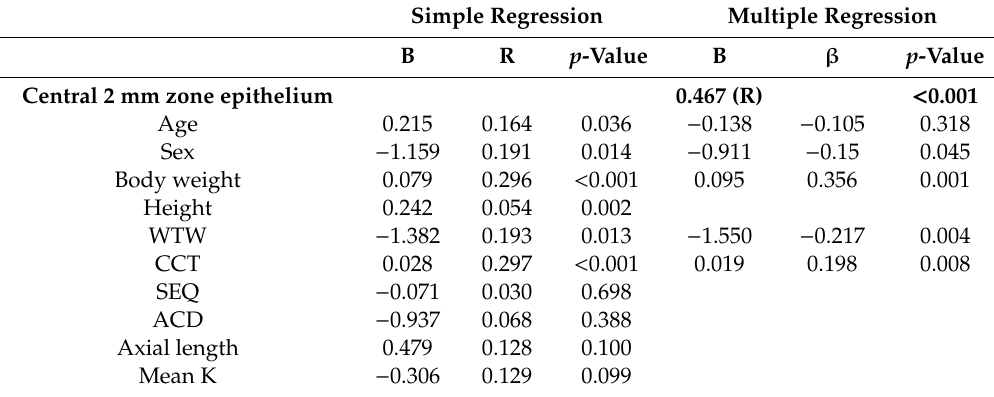
Table 3. Factors a ff ecting corneal epithelial and stromal thickness in the center in Korean school children Table 3. Factors affecting corneal epithelial and stromal thickness in the center in Korean school ( n = children ( n = 165).